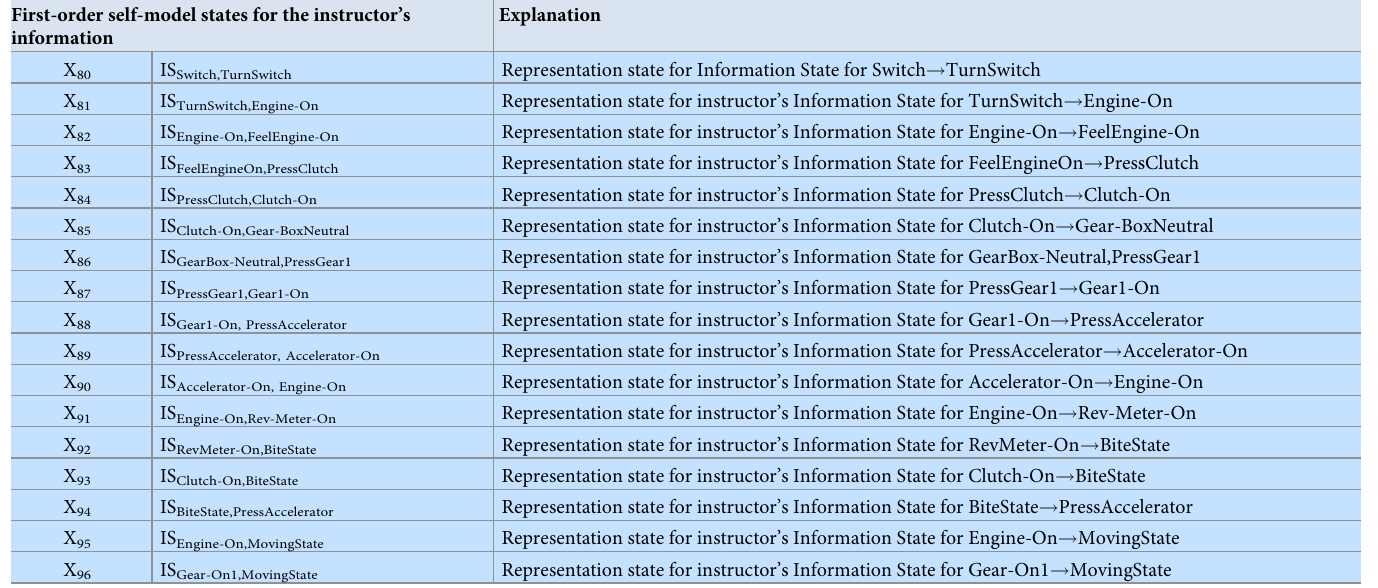
Table 5. Explanation of the first-order self-model states for the instructor’s Information States in the network model. First-order self-model states for the instructor’s